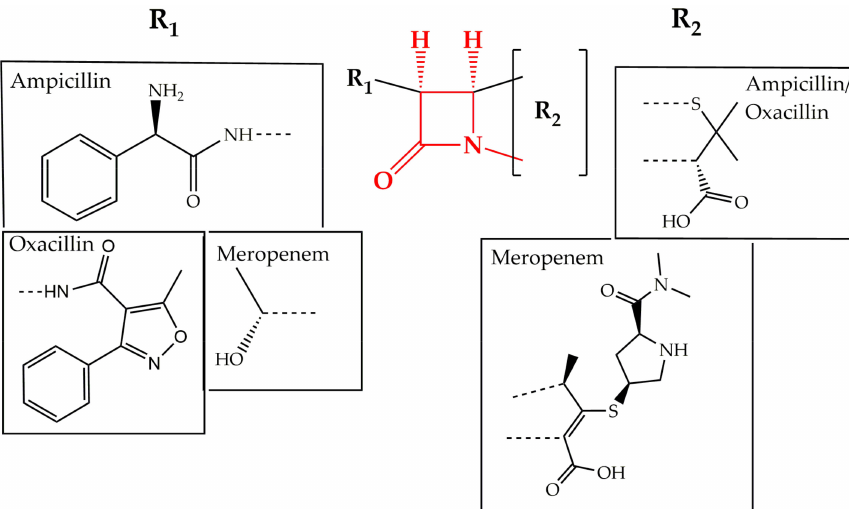
Figure 2. Chemical structure of conserved ring structure in β -lactam antibiotics and side-chain functionalities (R 1 and R 2 ) of three β -lactam antibiotics, ampicillin, oxacillin, and meropenem. Dashed lines represent the connecting bonds to the β -lactam ring ( red